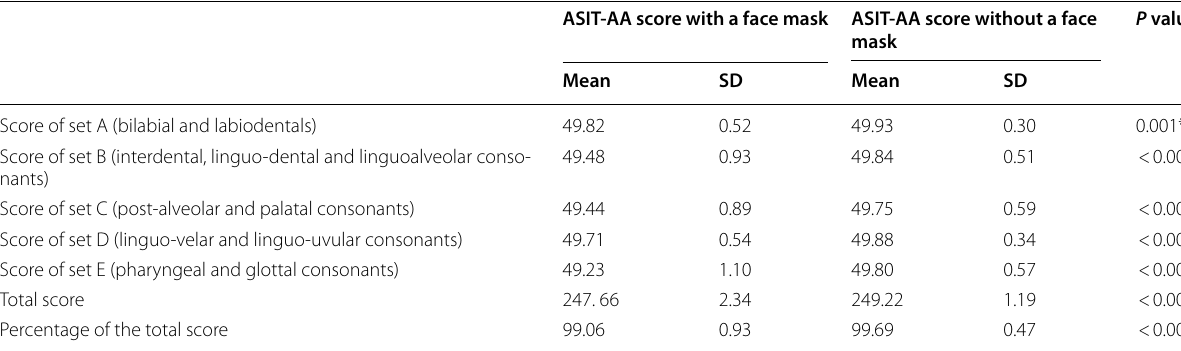
Table 9 Comparison between the ASIT‑AA score of each set and the total score with face mask and without face mask ASIT‑AA score with a face mask ASIT‑AA score without a face